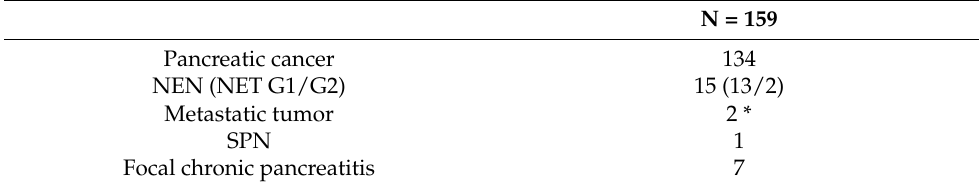
Table 3. Final diagnosis of the patients who underwent EUS-FNB.